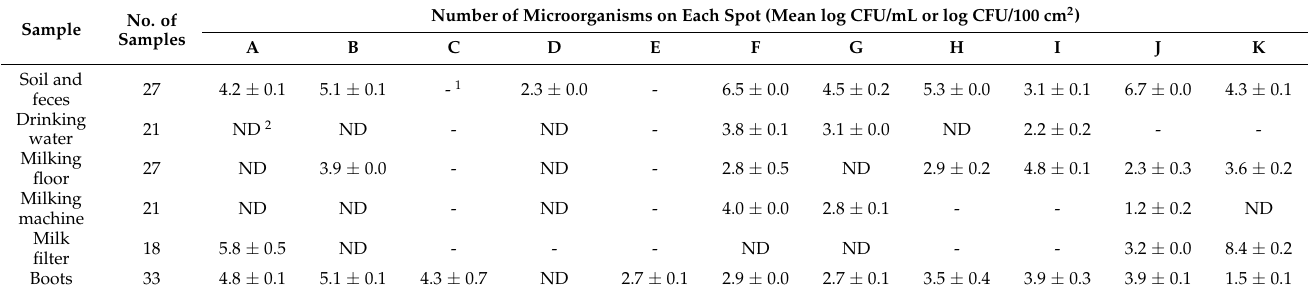
Table 6. Mean ( ± SD) yeast/mold counts in the environment of each dairy farm (A to K). Sample